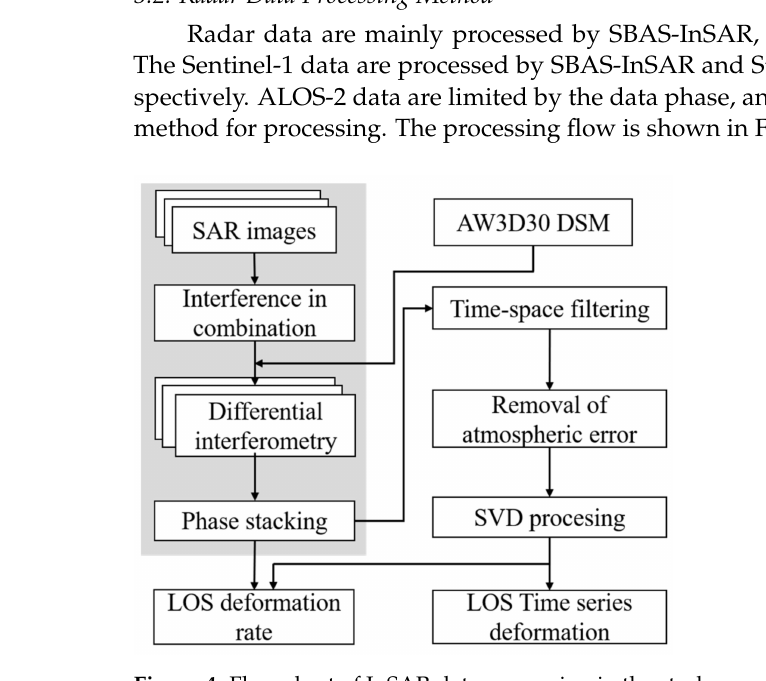
Figure 4. Flow chart of InSAR data processing in the study